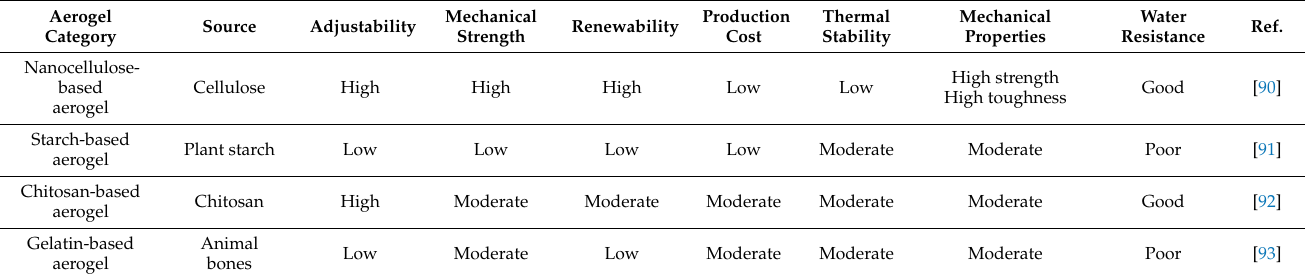
Table 3. Comparison of the properties of nanocellulose-grade aerogels with those of other natural material-based